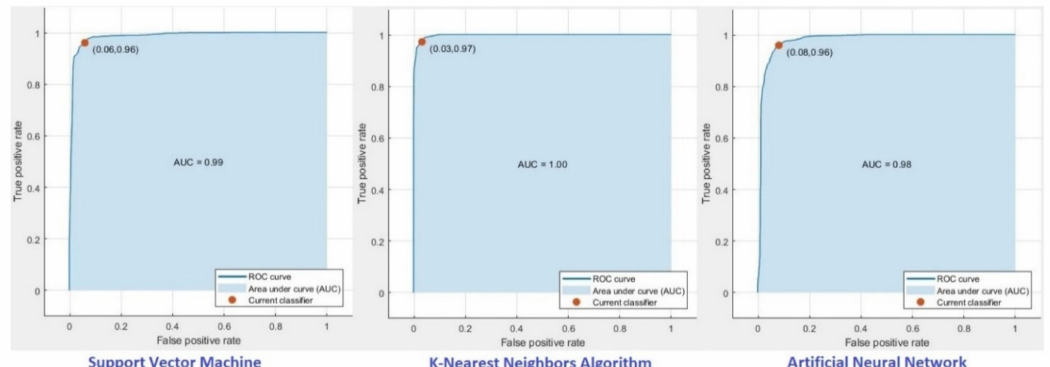
Figure 3. Receiver operating characteristic (ROC) curve results of the classification